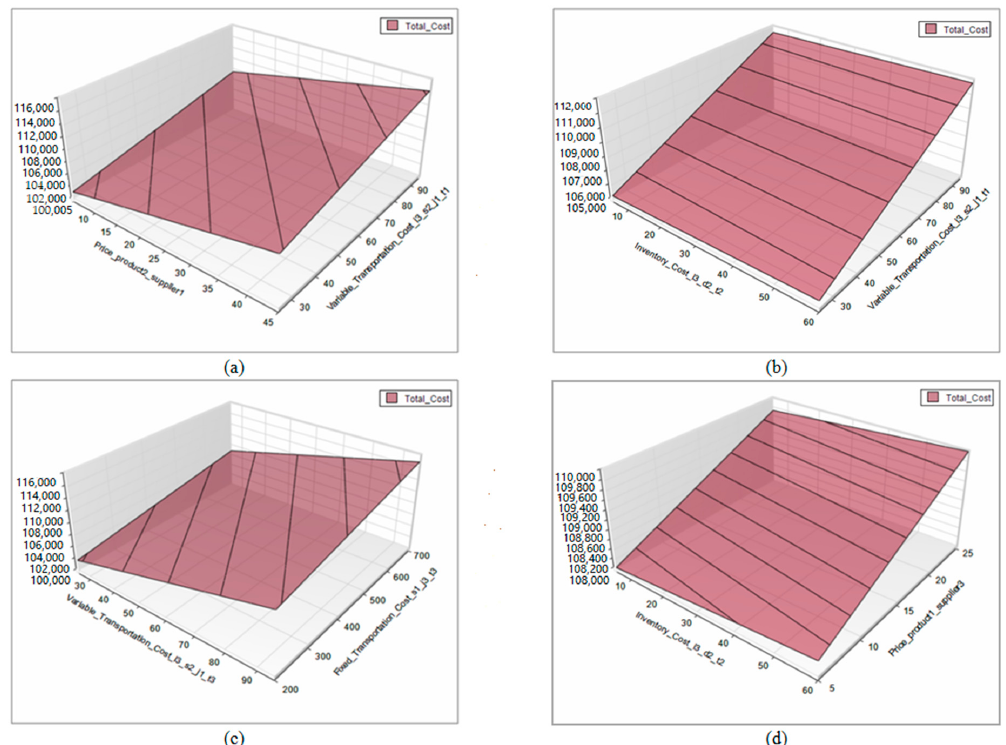
Figure 5. Graphs of the objective value by varying two parameters independently: ( a ) “Price_i2_s1” and “Var.Transp.Cost_i3_s2_j1_t1”, ( b ) “Var.Transp.Cost_i3_s2_j1_t1” and “Invent.Cost_i3_d2_t2”, ( c ) “Var.Transp.Cost_i3_s2_j1_t3” and “Fix.Transp.Cost_s1_j3_t3”, ( d ) “Invent.Cost_i3_s2_j1_t1” and Table 3. Sensitivity analysis report for simultaneous variations in the highest-impact parameters.